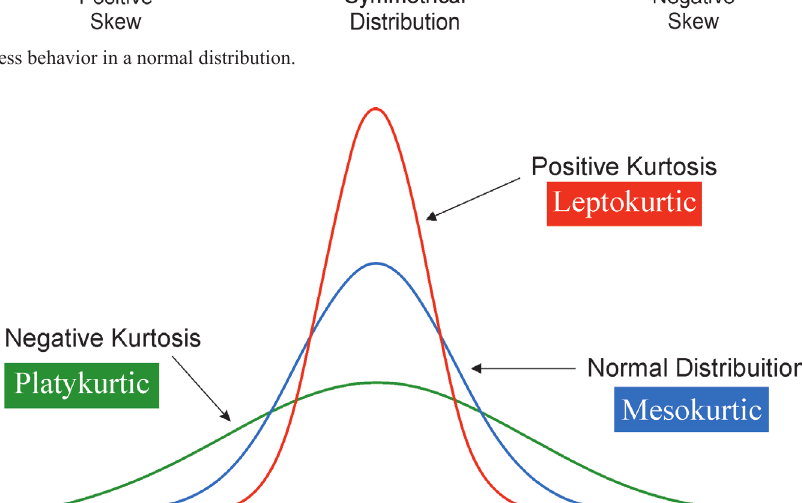
Figure 5. Kurtosis behavior in a normal distribution.